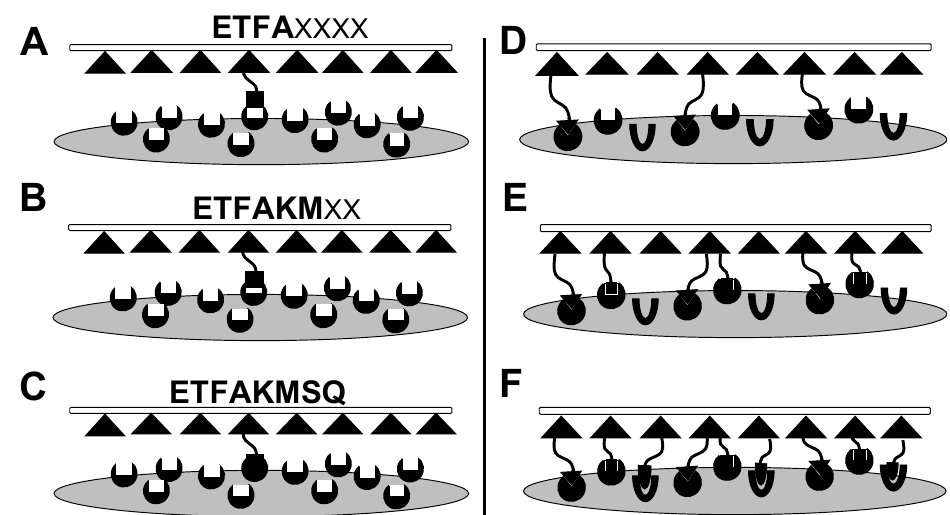
Figure 4. Affinity maturation ( A – C ). Selection of phage peptide sequences based on monovalent interactions with an immobilized target. Populations are enriched by increasing the stringency of a selective pressure, in this example binding to an immobilized target, through multiple rounds of selection. ( A ) In the first round of selection, phage bind through relatively weak, monovalent interactions as populations of phage compete for a primary binding site involving relatively few residues. ( B , C ) In the second and subsequent rounds of selection, the stringency is increased for improved binding, which results in phage populations with involvement of more residues in the ligand-target binding site and increased a ffi nity towards the target. Combinatorial avidity selection ( D – F ). Enrichment of SLiMs based on multiple, low a ffi nity, multivalent interactions between neighboring targets within the same particle. Populations are enriched by accumulation of multiple core motifs (CorMs) with low a ffi nity, but increasing overall avidity, as the result of multiple, multivalent ligand-target interactions in the same ligand. ( D ) CorMs enriched in the first round of selection may either proceed through successive rounds by the traditional a ffi nity maturation to form active SLiMs. ( E ) Alternatively, active SLiMs may be enriched by shu ffl ing CorMs that increase avidity to the complex target surface. Here, two theoretical CorMs (triangle and square) are displayed on particles with the first interacting CorM. When no additional targets are free to bind available ligands, avidity should increase through binding of a second CorM located on the same particle that increases fitness through successive rounds of selection with stronger stringency. ( F ) Additional CorMs may also accumulate (oval) to increase the total avidity of the